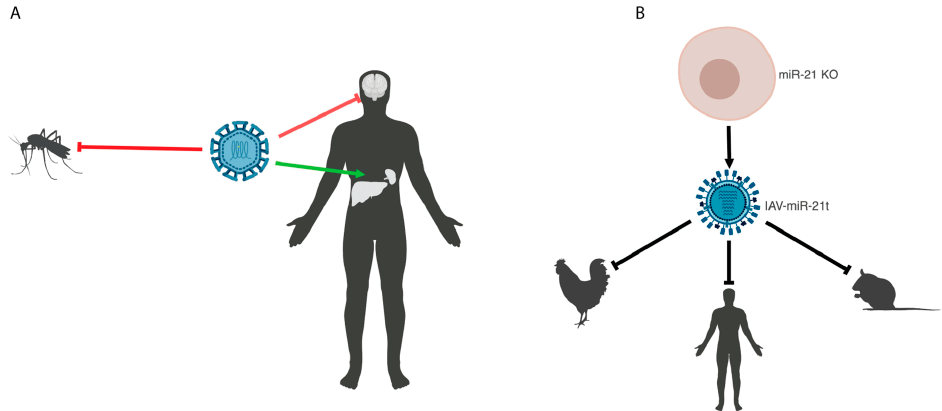
Figure 1. Tissue- and species-specific microRNA-attenuated viruses. ( A ) Model of tissue-specific attenuation of a flavivirus combined with attenuation in an insect vector. ( B ) Model depicting generation of a miRNA-attenuated influenza A virus in miRNA knock out cells to generate a species-universal attenuated vaccine. Created with BioRender (Toronto, ON,